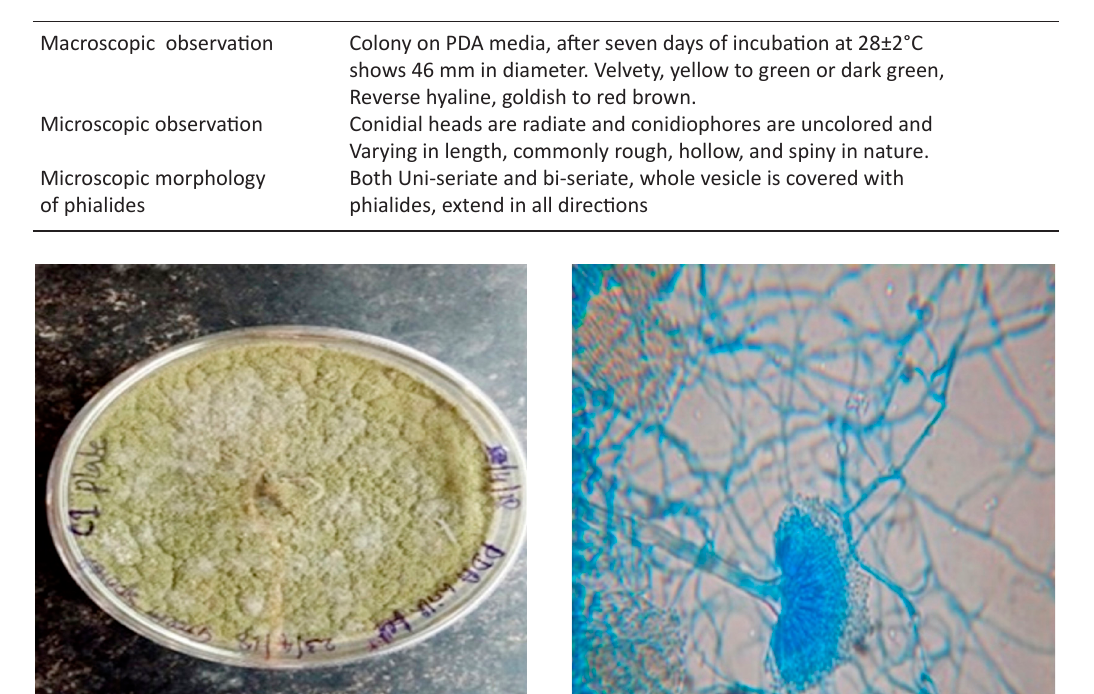
Table 1. Characteristics of A. flavus